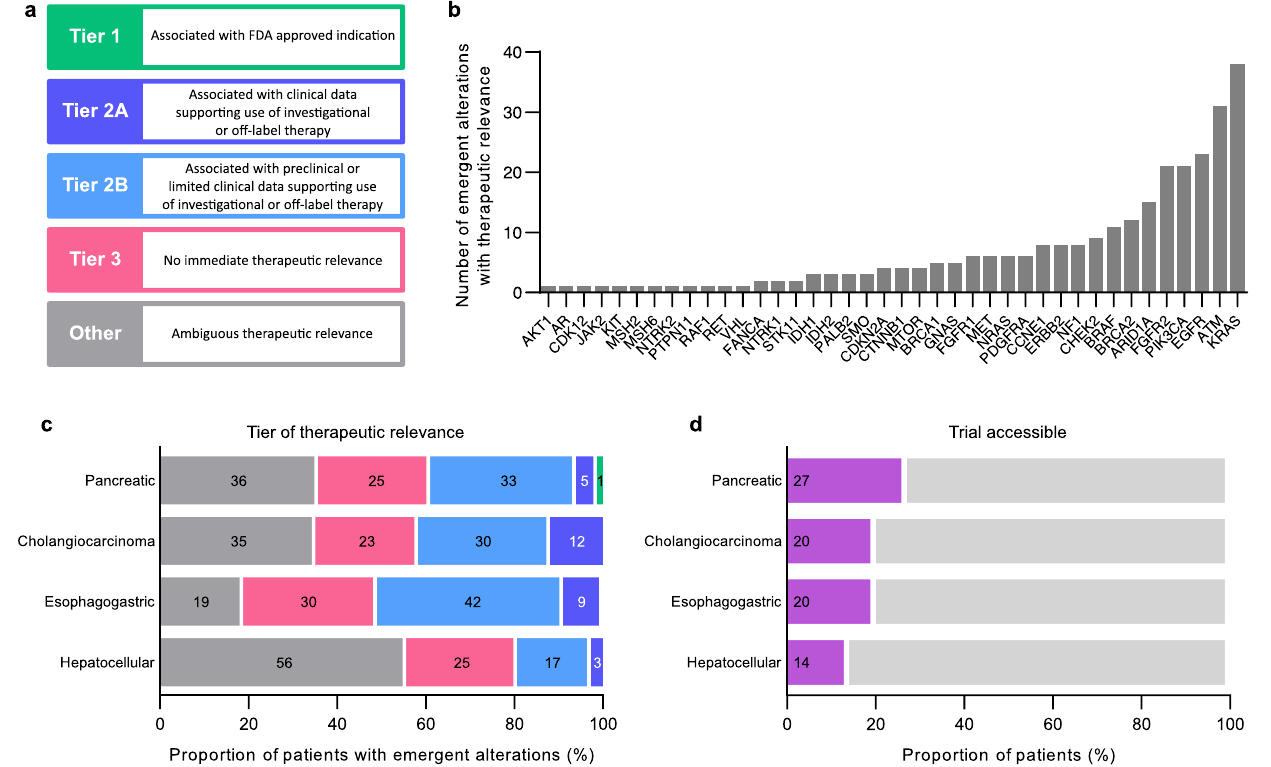
Fig. 4 | Therapeutic relevance of emergent ctDNA alterations. a Tiers of evi- dence used by the molecular tumor board to classify emergent ctDNA alterations by therapeutic relevance. b Distribution of therapeutically relevant alterations across genes. c Patients with emergent ctDNA alterations were categorized by the